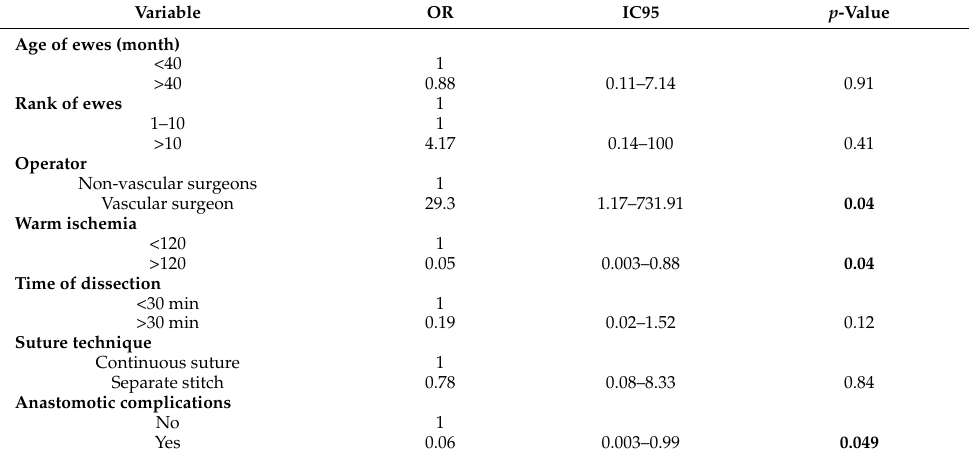
Table 3. Multivariate analysis of factors predicting successful venous anastomosis immediately after surgery.